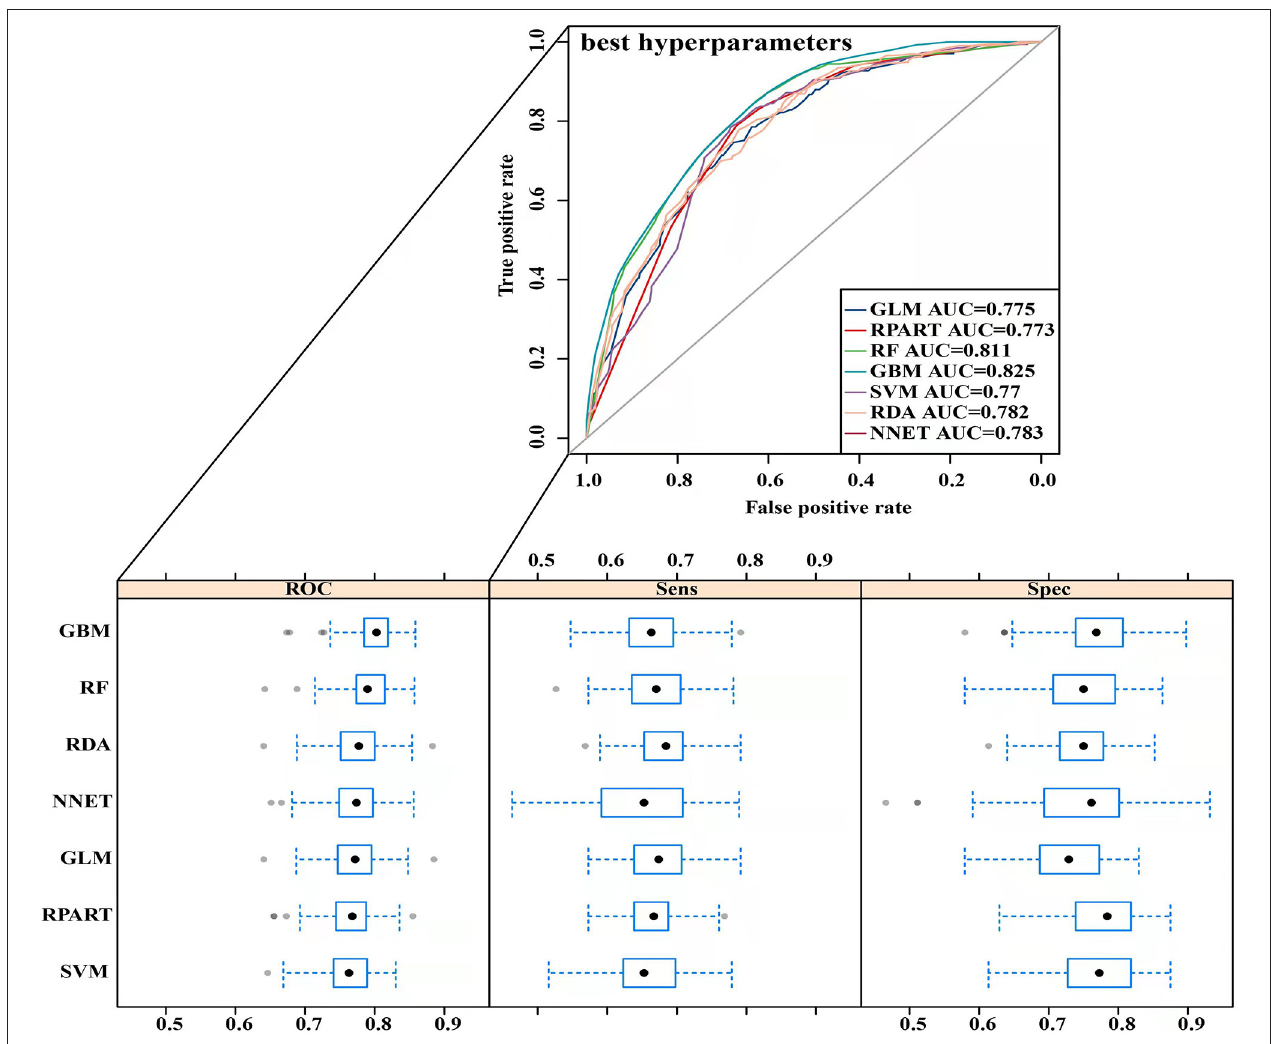
FIGURE 2 | Receiver operating characteristic (ROC) curve of the training set prediction